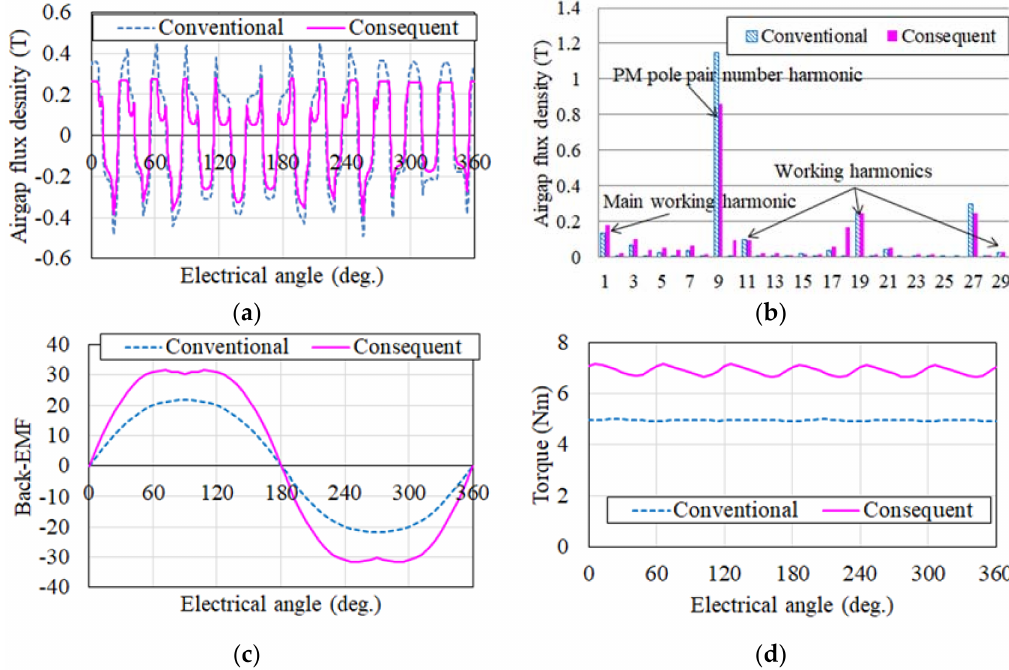
Figure 3. Machine performance comparison: ( a ) Airgap flux density. ( b ) Magnitudes of harmonics. ( c ) Back-EMF. ( d )